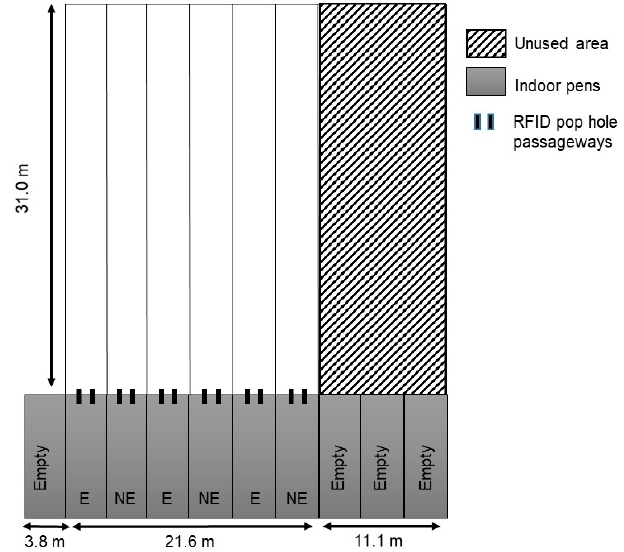
Figure 1. The experimental free-range facility showing the 6 indoor pens connected to separate outdoor range areas and the two radio-frequency identification (RFID) passageways within each pop-hole. Each pen housed birds from either enriched (E) or non-enriched (NE) rearing treatments.